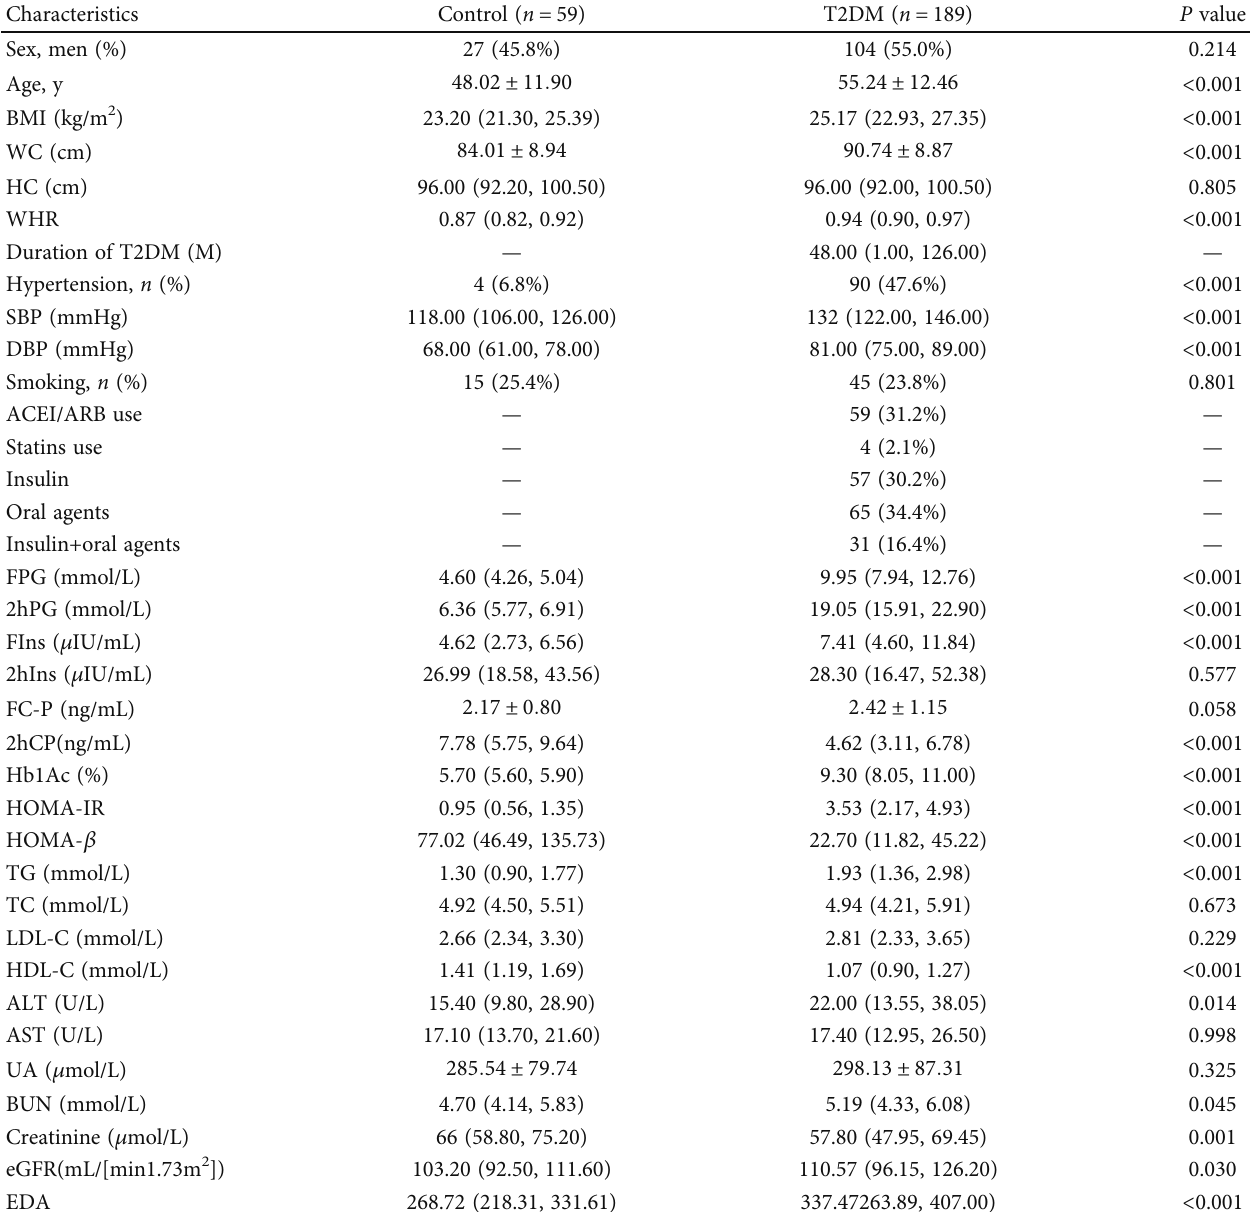
Table 1: Baseline clinical characteristics of all